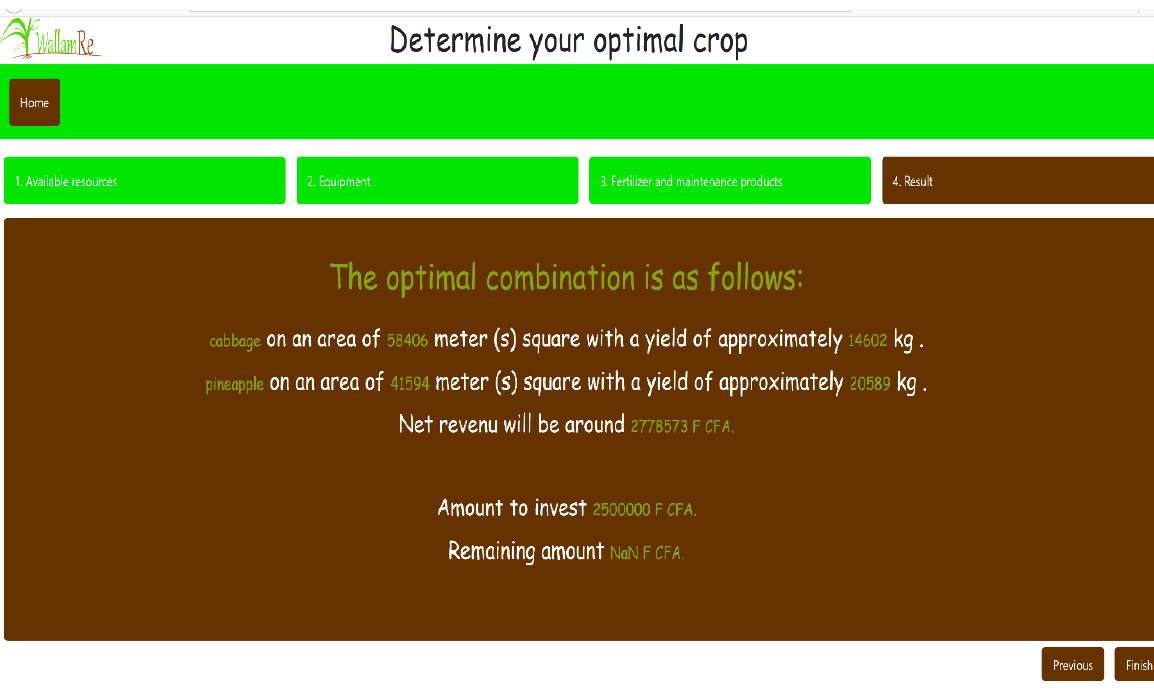
Figure 9. Interface to show the final